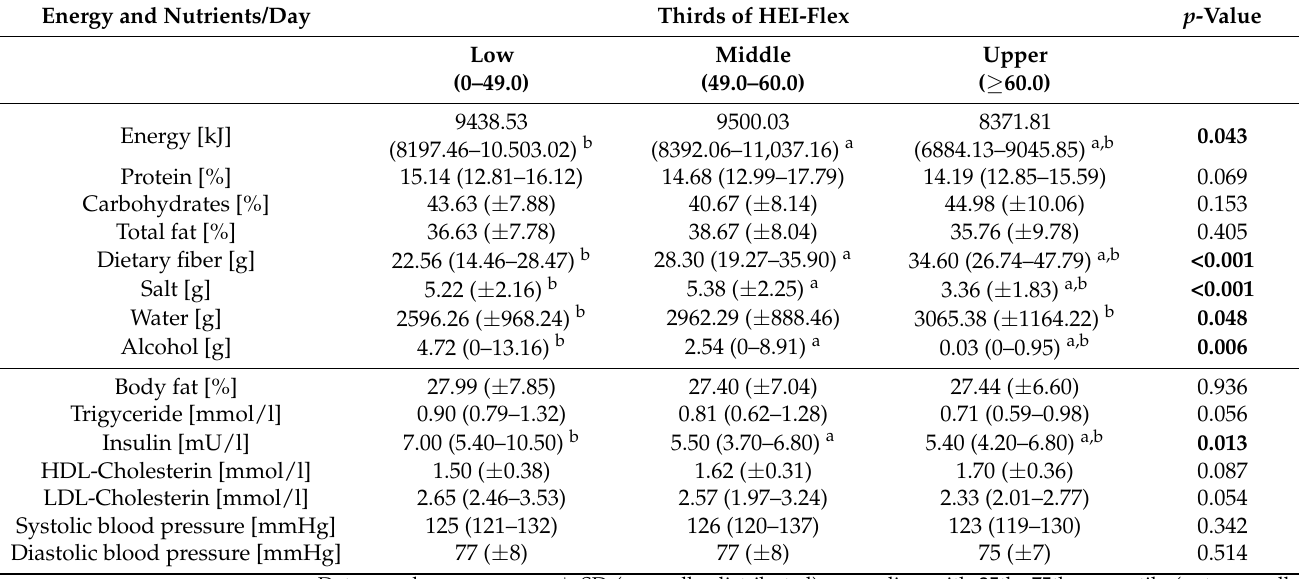
Table 5. Indications of construct validity: Macronutrient intake and cardiovascular risk parameters according to distribution thirds of